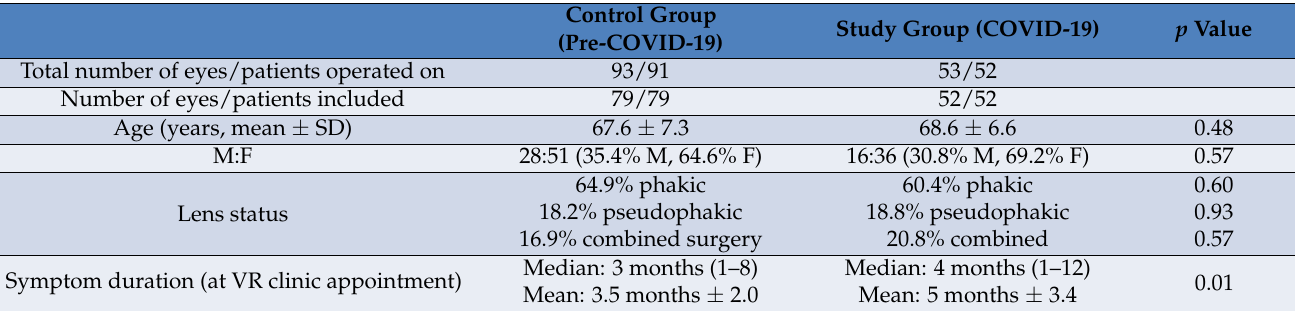
Table 1. Demographic characteristics of the